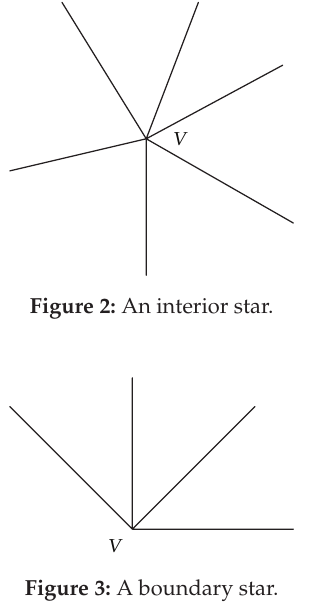
Figure 3: A boundary